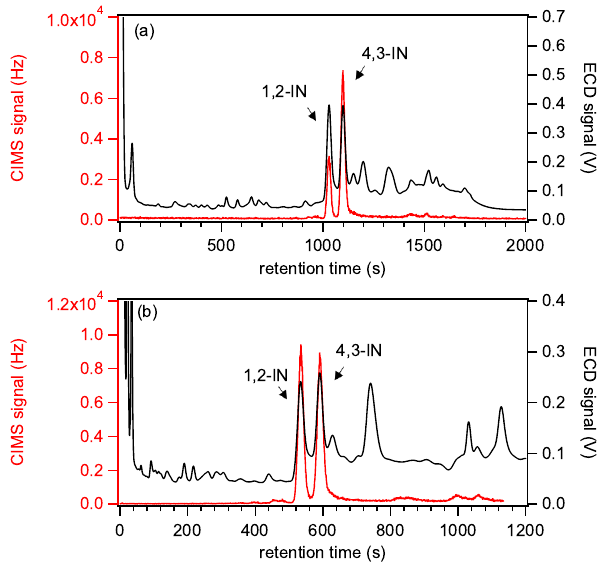
Figure 2. GC-ECD/CIMS chromatogram with water (a) and with- out water (b) added to the CIMS. The ECD signal is in black and the CIMS signal is in